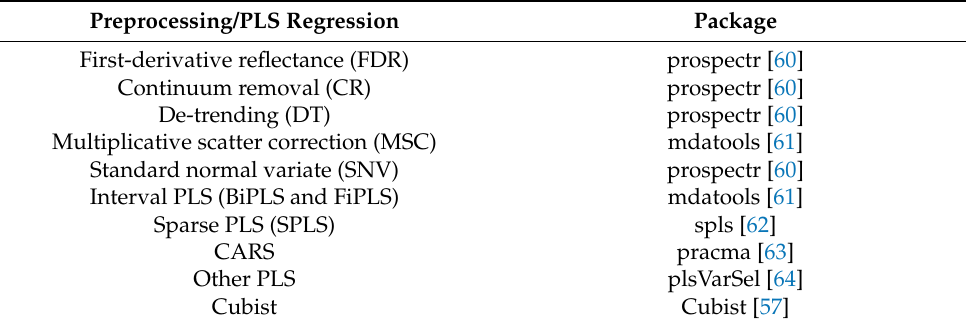
Table 2. Software and packages used in this